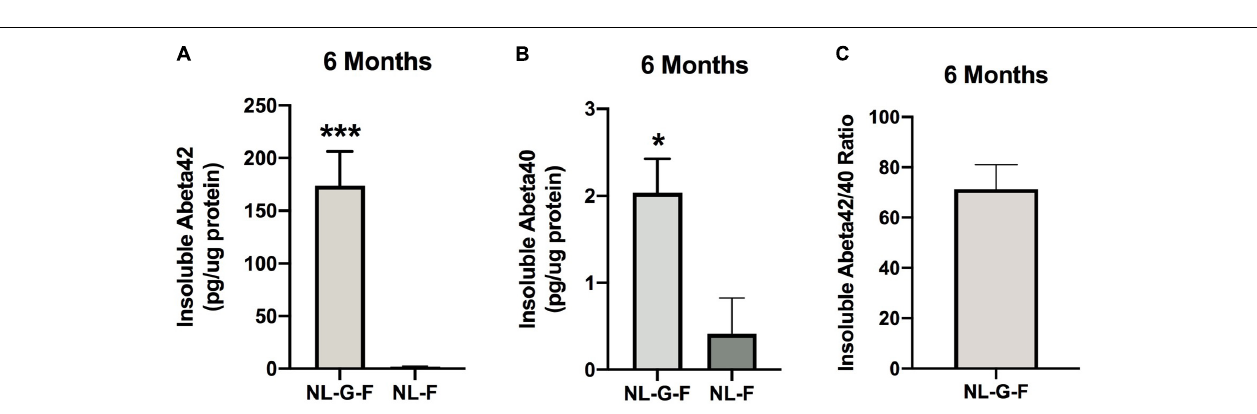
FIGURE 12 | (A) Insoluble A β 42 levels were higher in NL-F/E4 than NL-F/E2 and NL-F/E3 mice. * p = 0.0106, **** p = 0.0074. (B) There was a trend toward higher soluble A β 42 levels in NL-F/E4 than NL-F/E3 mice. # p = 0.0852. (C) There was no effect of genotype on soluble A β 40 levels. (D) There was no effect of genotype on the soluble A β 42/40